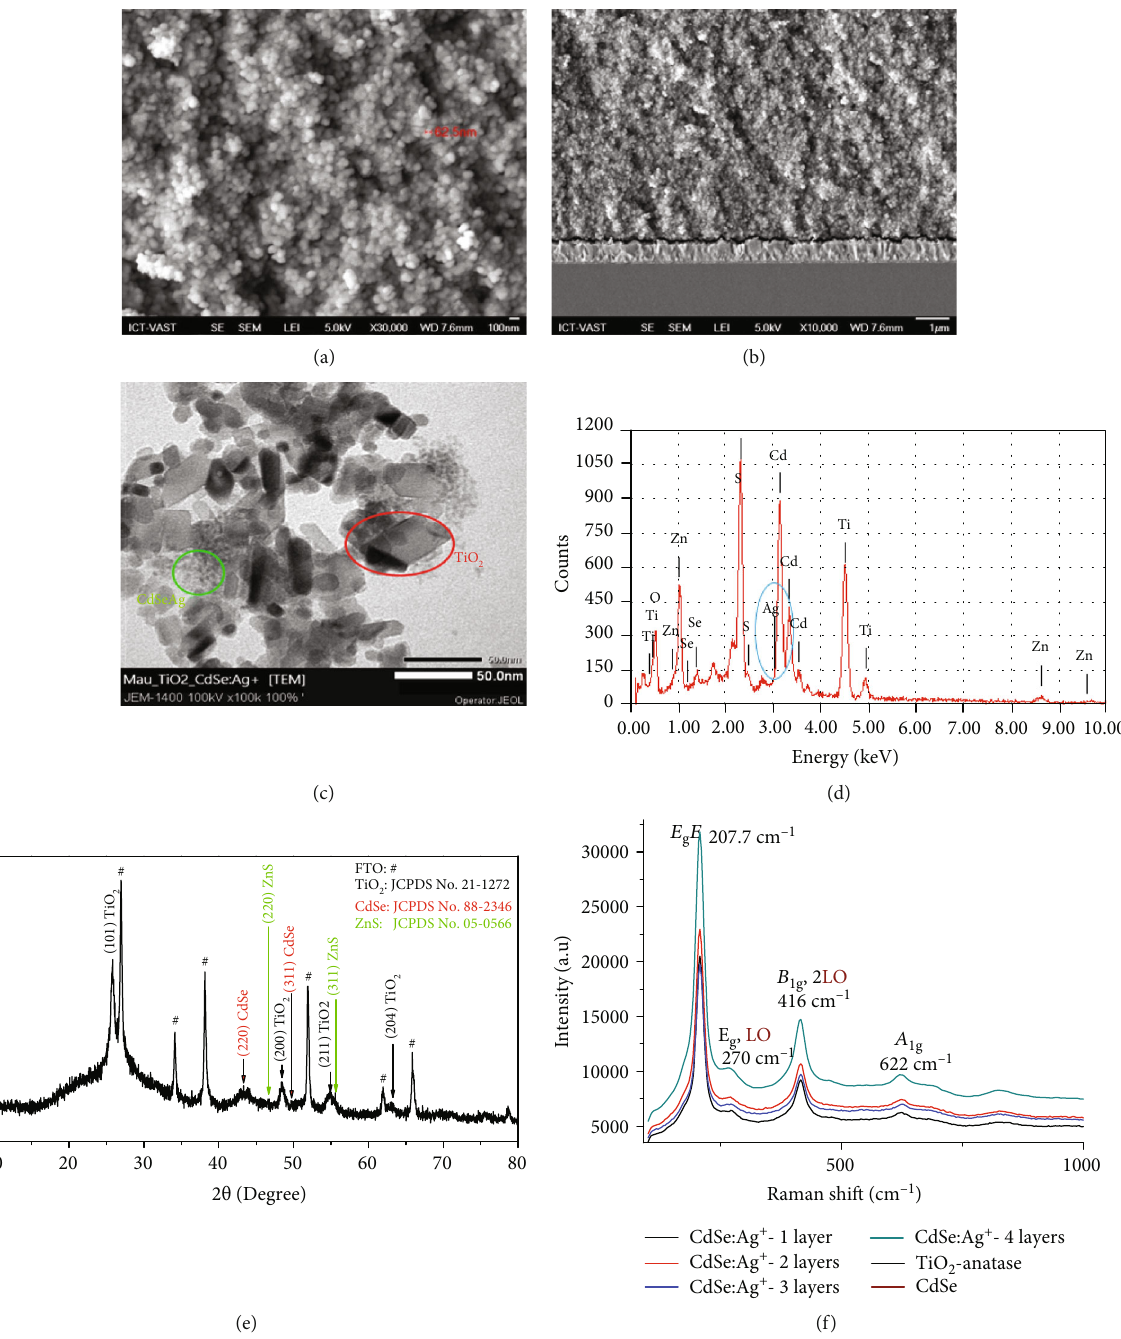
Figure 1: (a) FESEM image, (b) Cross-section, (c) TEM, (d) EDX spectrum, and (e) XRD pattern of TiO Raman spectrum of photoanode with the di ff erent